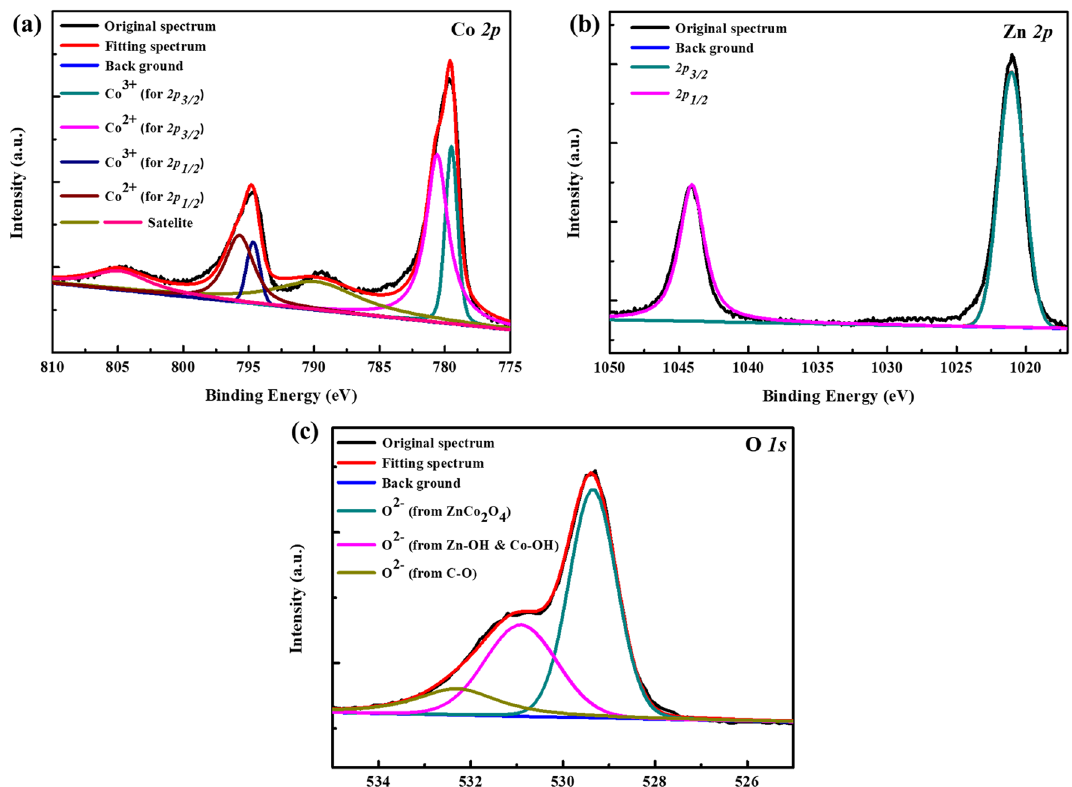
Figure 3. High-resolution XPS spectra of ( a ) Co 2p , ( b ) Zn 2p , and ( c ) O 1 s elements in ZnCo 2 O 4